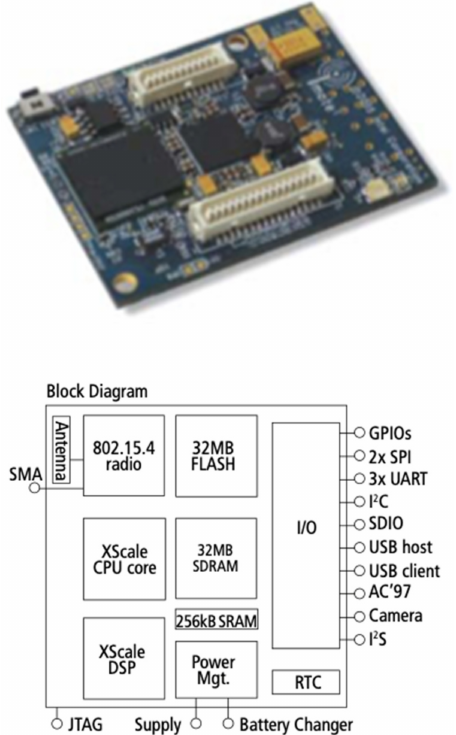
Figure 8. Pictorial description and illustration of Irene Mote